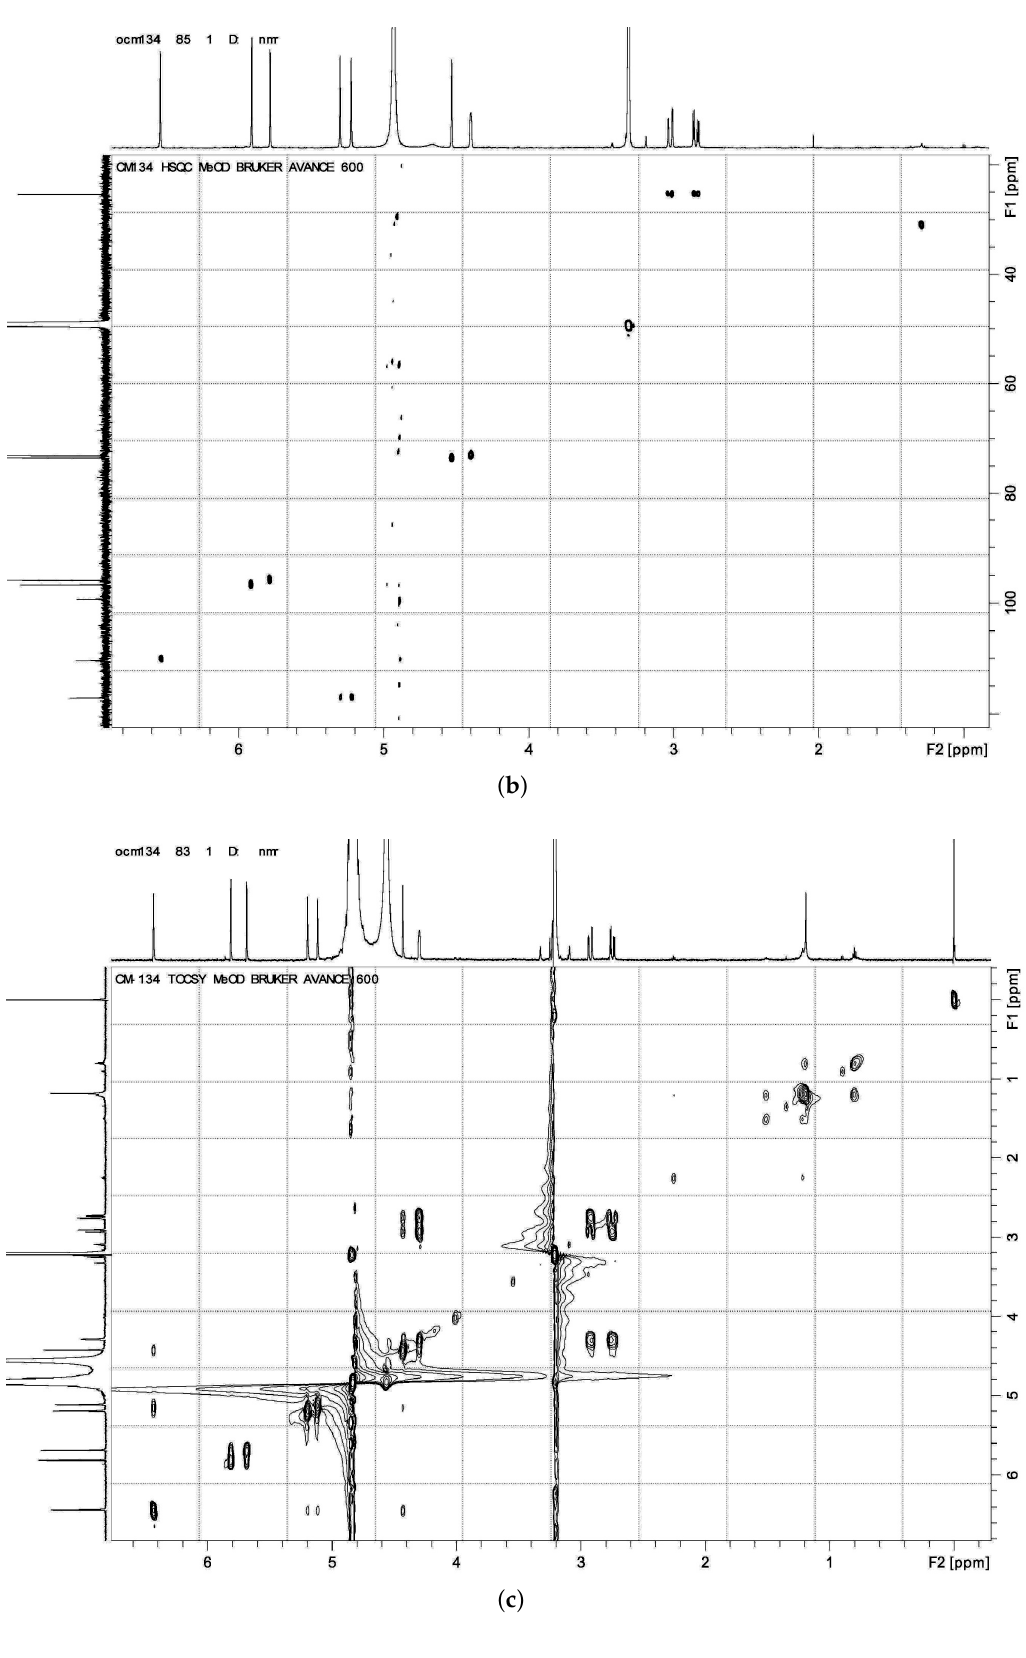
Figure 4. Nuclear Magnetic Resonance (NMR) spectrometry assay of compound 1: ( a ) Heteronuclear Multiple Bond Correlation (HMBC); ( b ) Heteronuclear Singular Quantum Correlation (HSQC); ( c ) Total Correlation Spectroscopy (TOCSY).